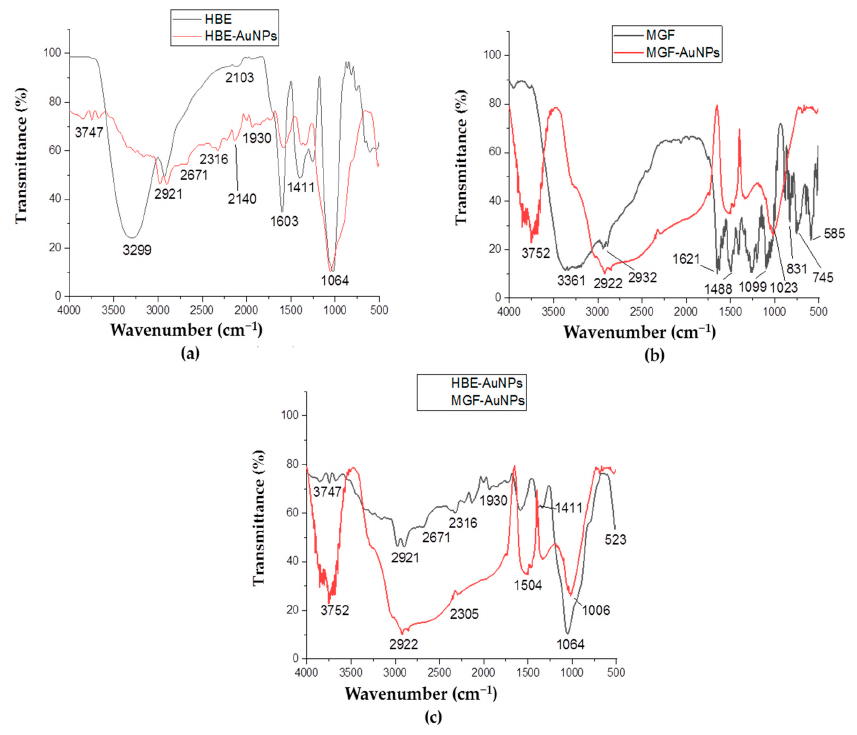
Figure 4. FTIR spectra of the HB and MGF extracts and their respective biogenic AuNPs. ( a ) HB-Extract and HB-AuNPs; ( b ) MGF-Extract and MGF-AuNPs; ( c ) HB-AuNPs and MGF-AuNPs.